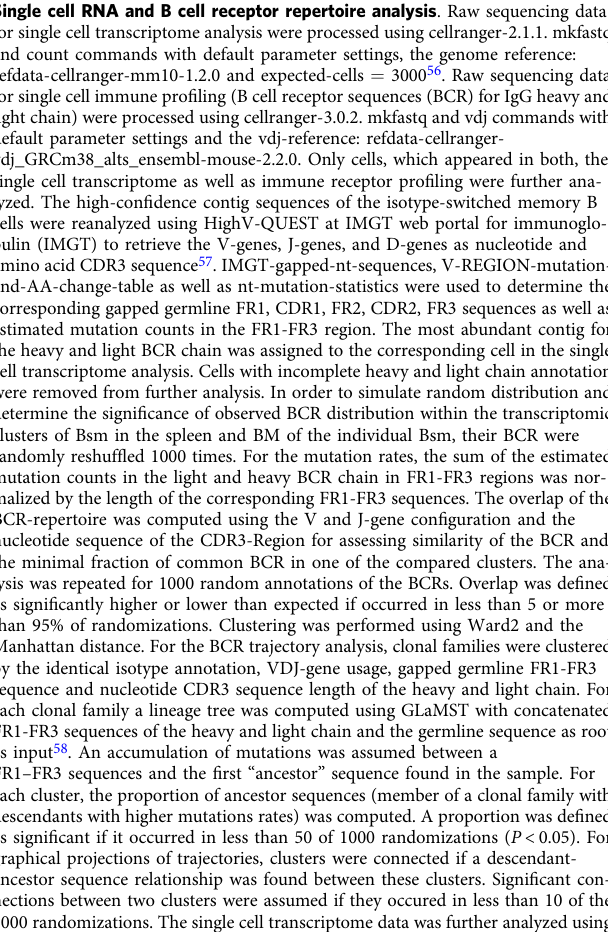
Fig. 4 Surface staining of CD21/35, CD23, CD5, and CD49d resolves six distinct populations of switched memory B cells in spleen and bone marrow. a , b Flow-cytometric identi fi cation of distinct populations among IgG + memory B cells gated as IgG1 + /IgG2b + CD19 + IgM − IgD − CD138 − GL7 − CD93 − live small lymphocytes (cf. Supplementary Fig. 5) in bone marrow (BM) ( a ) and spleen ( b ) of female C57BL/6 mice. CD21/35 and CD23 resolve three subsets resembling clusters I, II, and IV as identi fi ed by transcriptional pro fi les. Expression of CD5 separates the CD21/35 − CD23 − population to a subset resembling cluster VI while CD5 − cells are divided by high and intermediate staining of CD49d into two subsets, which differ in expression of CXCR3 and CD11b and resemble clusters III and V. Dotplots represent one of eight mice immunized 3× with NP-CGG/IFA. c Boxplots represent the frequency of subsets by cytometry according to expression of CD21/35, CD23, CD5, and CD49d among IgG + Bsm. A non-parametric ANOVA (Friedman test) was performed (Two-stage linear step-up procedure of Benjamini, Krieger, and Ykutieli) P < 0.0001, followed by a one-sided paired t -test between spleen and BM cluster IV and V, respectively, n = 8. Boxplot indicates median, fi rst and third quartiles, whiskers: 1.5 IQR. Source data for Fig. 4c is provided as a Source Data fi